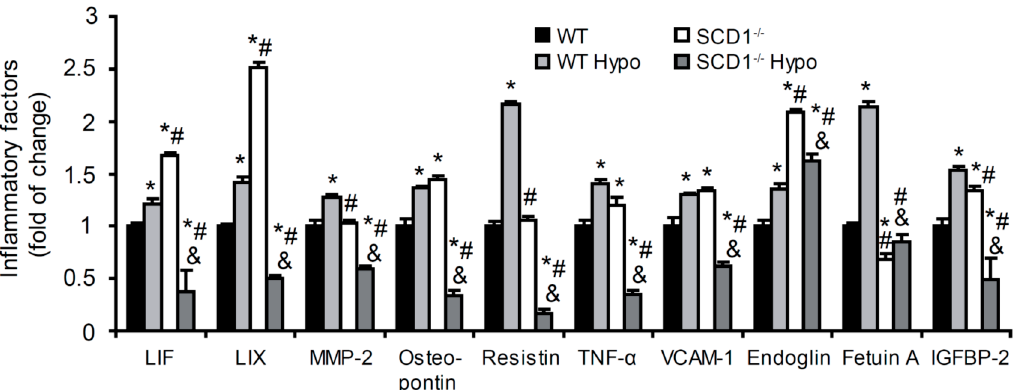
Figure 2. Effect of SCD1 deficiency on the protein content of inflammatory molecules in cardiomyocytes in control and hypothyroid mice. Cytokines and chemokines were measured using the Proteome Profiler Mouse Cytokine Array kit (R&D Systems) according to the manufacturer’s procedures. LIF, leukemia inhibitory factor; LIX, C-X-C motif chemokine 5; MMP-2, matrix metalloproteinase 2; TNF- α , tumor necrosis factor α ; VCAM-1, vascular cell adhesion molecule 1; IGFBP-2, insulin-like growth factor-binding protein-2. The data are representative of n = 5 animals/group. The data are expressed as mean ± SD. * p < 0.05, vs. WT; # p < 0.05, vs. WT Hypo; & p < 0.05, vs. SCD1 -/- .